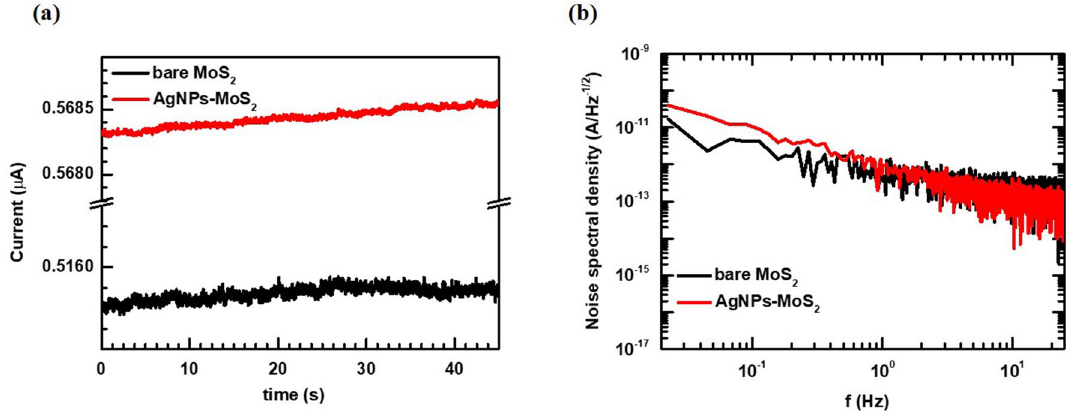
Figure 4. ( a ) Dark current waveform of the bare and plasmonic MoS 2 photodetectors. ( b ) Analysis of the noise spectral density of the bare and plasmonic MoS 2 photodetectors.